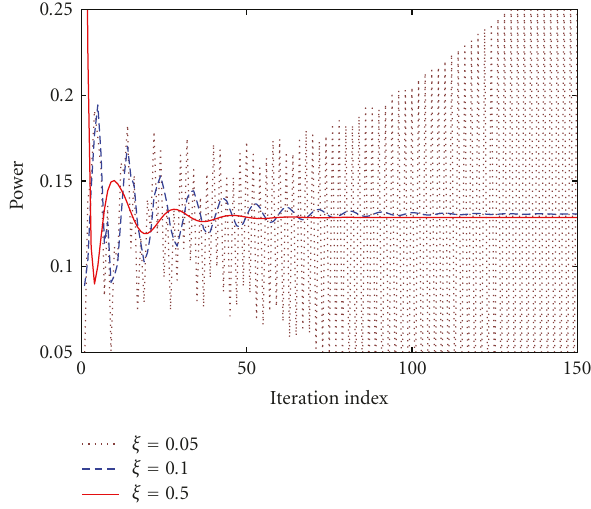
Figure 2: Illustration of P l ( i ) ( k ) of the DCLS algorithm with K = 3 and λ = 5 for the ring network versus the iteration index i for an arbitrary choice of l and k and di ff erent values of ξ . This particular link l is scheduled to be on in the slot k since P l ( i ) ( k ) converges to a nonzero value (for ξ ≥ 0 .